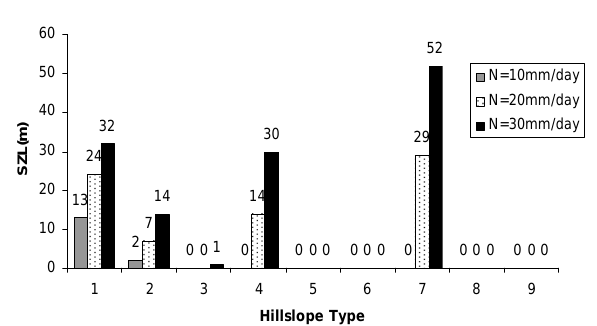
Fig. 6. Saturation zone length (SZL) for different recharge ratios.